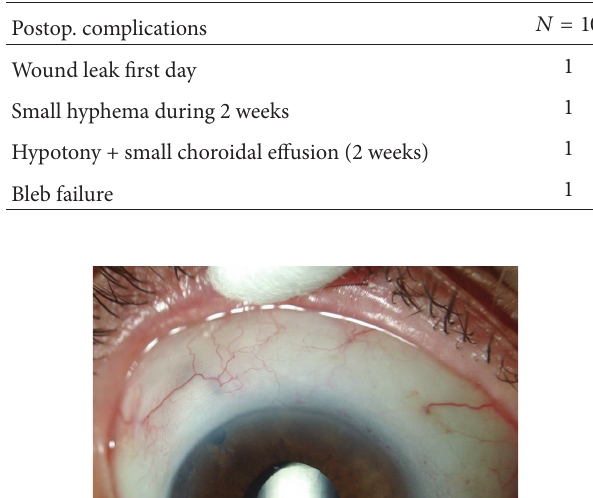
Table 2: Postoperative complications. Postop. complications